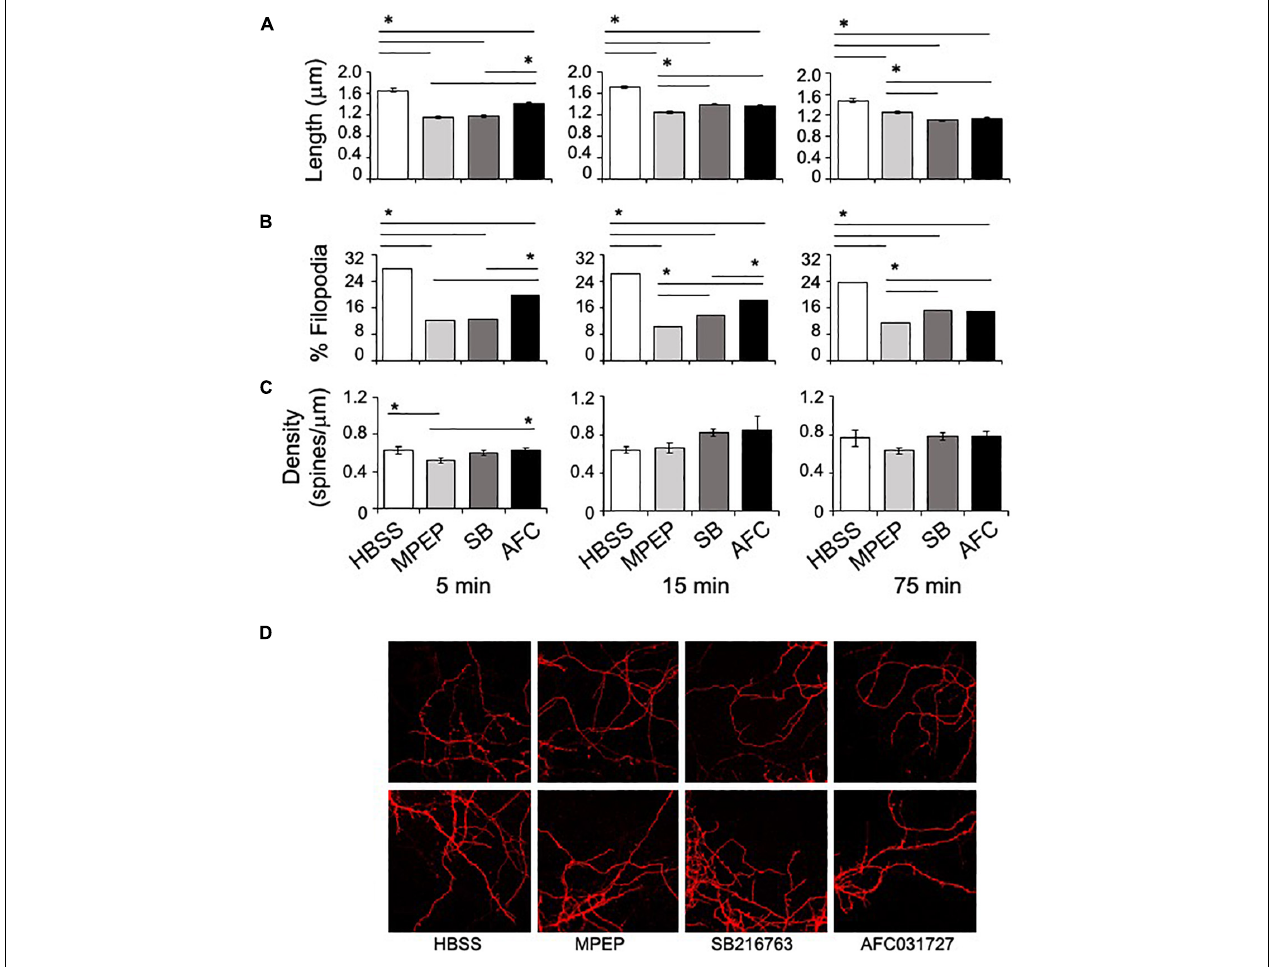
FIGURE 4 | GSK3 inhibitors rescue dendritic spine morphology phenotypes in Fmr1 KO mice. (A) Primary cultured Fmr1 KO neurons were treated with 25 µ M MPEP versus 25 µ M SB216763 and 250 nM AFC03127 for 5, 15, or 75 min, stained with DiI and images acquired with an 100x objective. The lengths of dendritic protrusions were quantitated with ImageJ software and plotted against compound treatment. Statistical significance was determined by ANOVA [5 min ( p < 0.0001, F = 101.8, and dF = 3); 15 min ( p < 0.0001, F = 67.61, and dF = 3); and 75 min ( p < 0.0001, F = 69.17, and dF = 3)]. Error bars represent SEM. Asterisks denote statistically significant differences by post hoc Tukey tests ( p < 0.001). (B) The percentage of filopodia was plotted against compound treatment. Filopodia were defined as protrusions with a width-to-length ratio less than or equal to 0.5. Statistical significance was determined by Chi square analyses (4 × 2 tables) [5